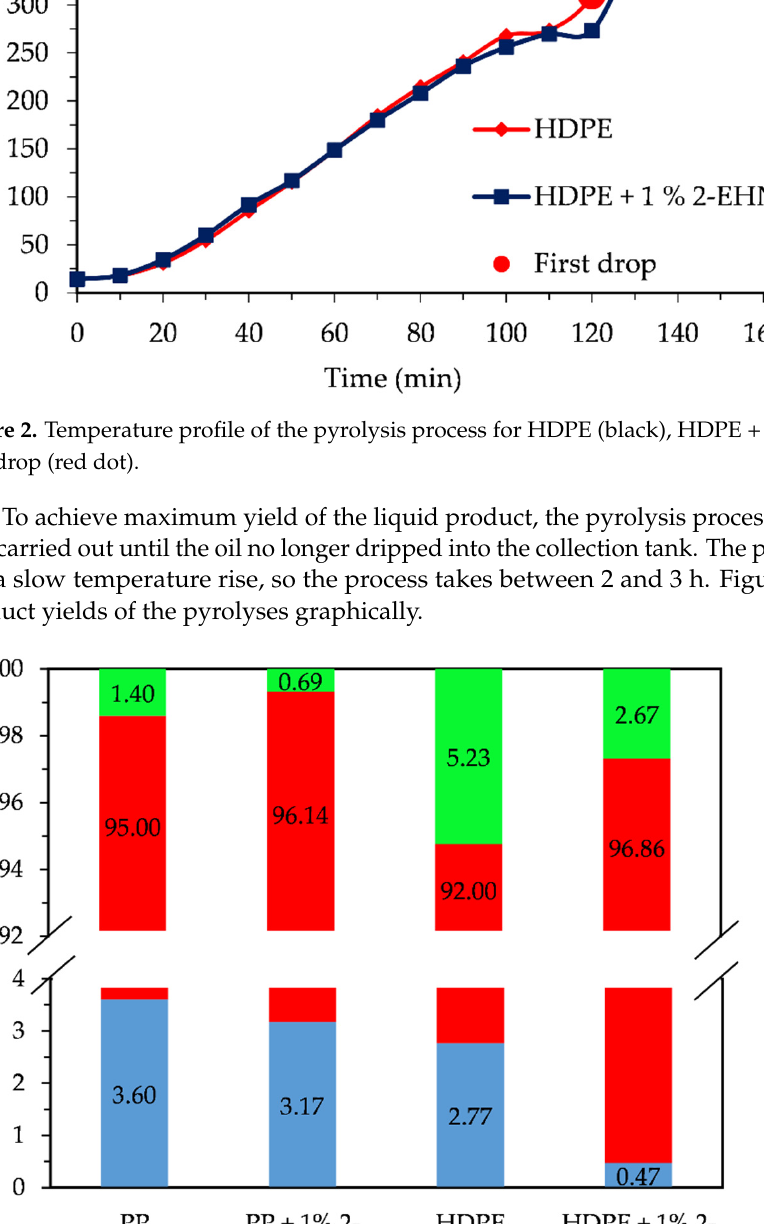
Figure 2. Temperature profile of the pyrolysis process for HDPE (black), HDPE + 1% 2 ‐ EHN (red), first drop (red dot).